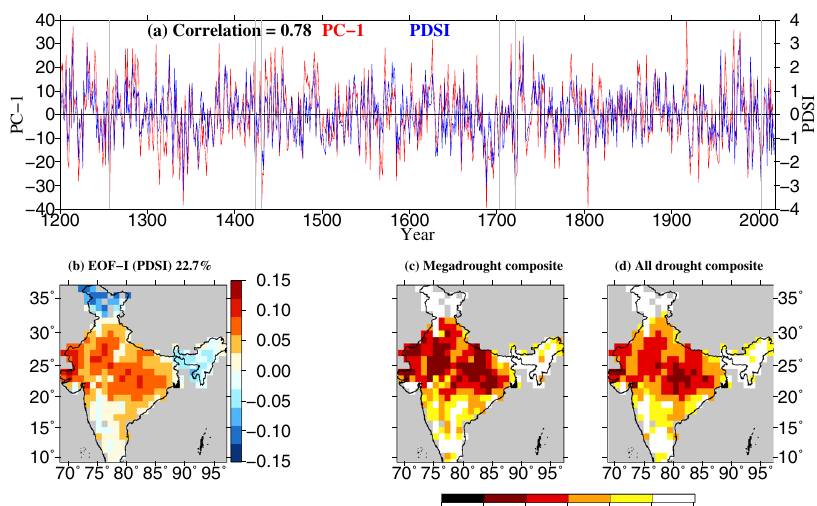
Fig. 3 Dominant mode of variability of summer monsoon droughts during 1200 – 2018. a Correlation between a principal component of the leading mode (PC-1) obtained from the empirical orthogonal function (EOF) analysis of PDSI and original PDSI time series, b leading mode of EOF analysis (EOF-1), c composite of the six megadroughts that occurred during 1200 – 2018, and d composites of all the drought with all- India averaged PDSI less than − 1.5 and area more than 40% occurred during the entire